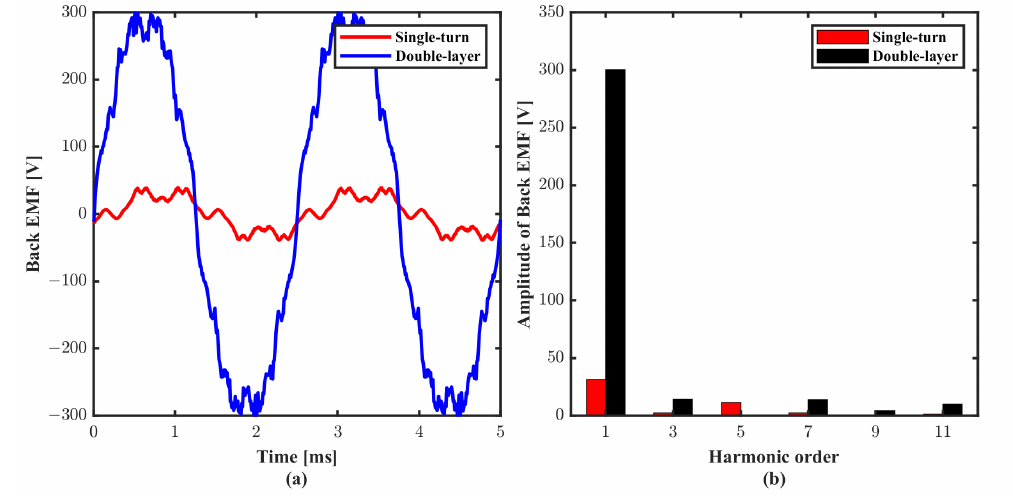
Figure 8. ( a ) The amplitude of Back EMF. ( b ) Harmonic content of Back EMF.